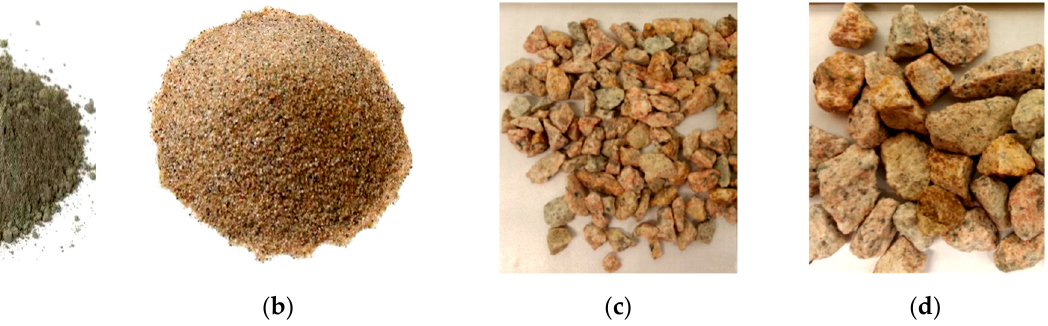
Figure 1. Particle size distribution of ( a ) natural coarse aggregate and ceramic coarse aggregate; ( b ) natural fine aggregate and ceramic fine aggregate.